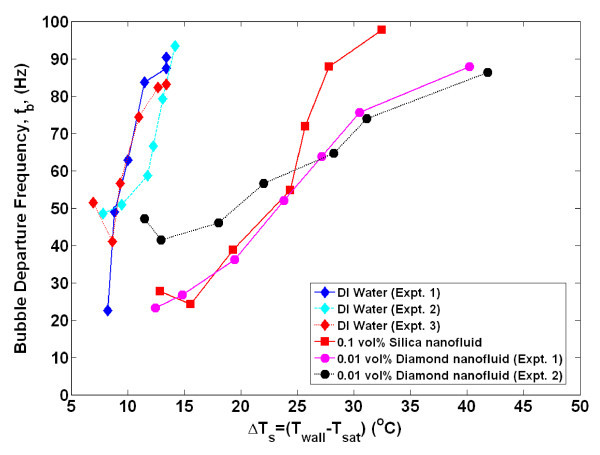
Average bubble departure frequency as measured by infrared thermometry. Uncertainty in departure frequency is ± 20%.